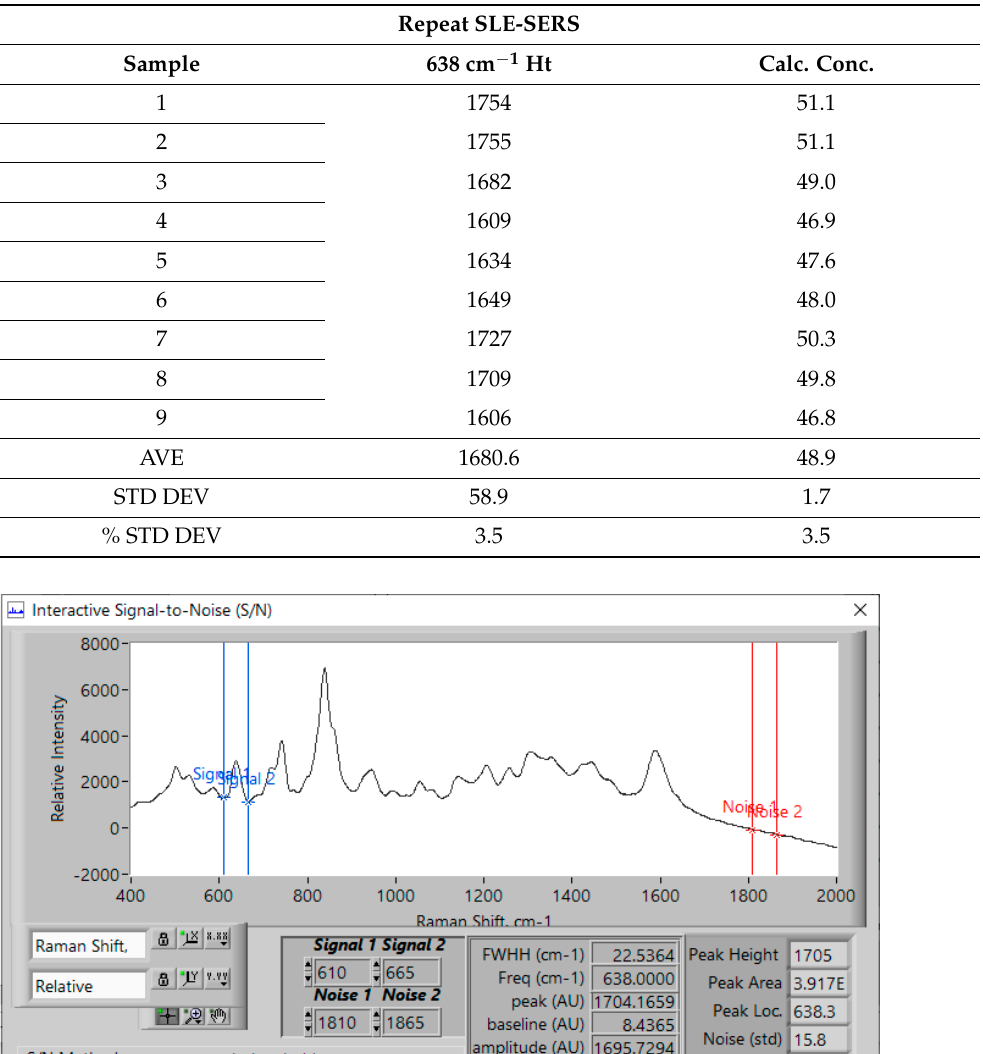
Table 3. Corresponding buprenorphine 638 cm − 1 peak heights.